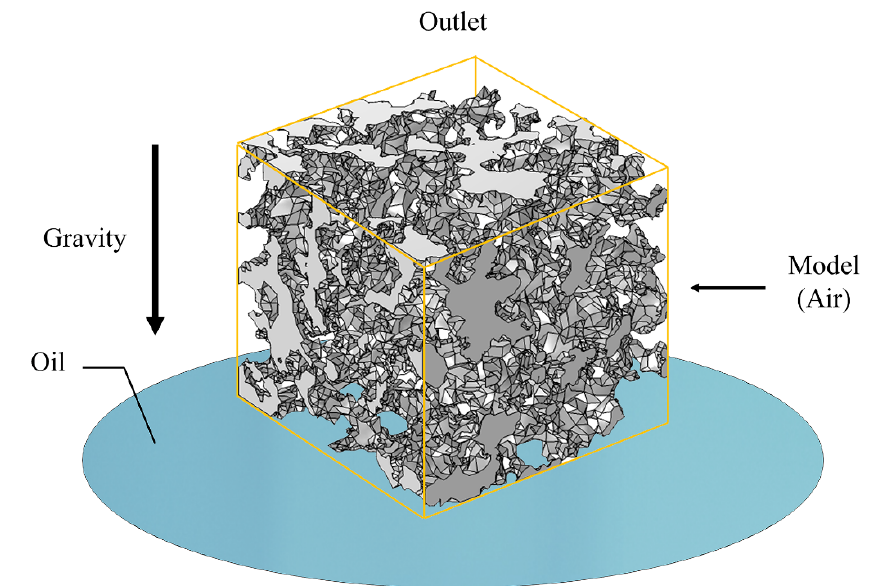
Figure 19. Boundary conditions for capillary force simulation.